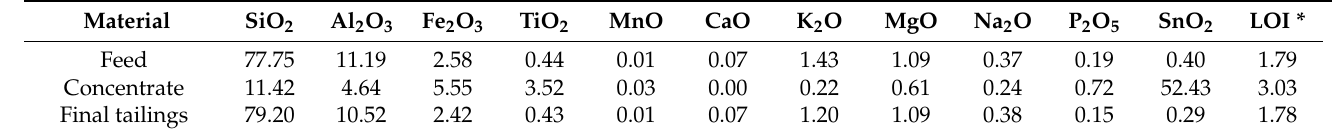
Table 1. Chemical composition, in wt.%, of the tailings and processing products from the C-4 processing